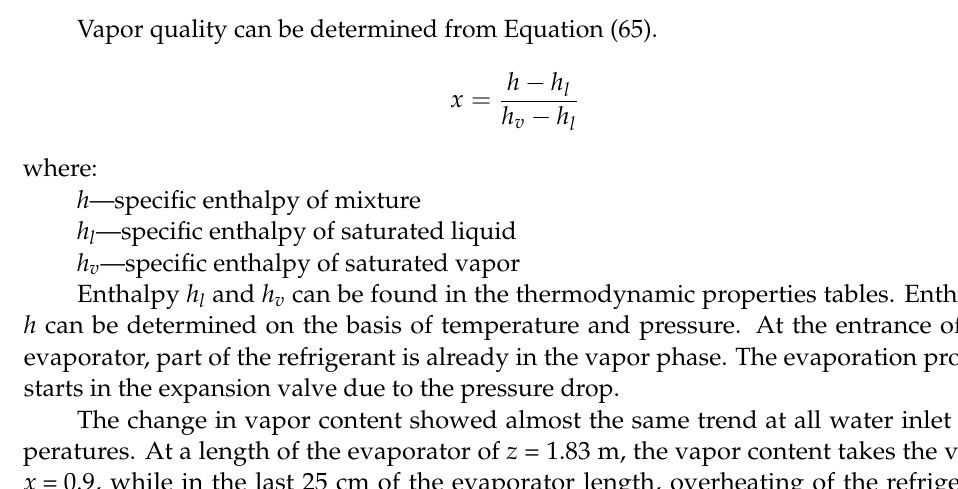
Figure 5. Variation of refrigerant vapor